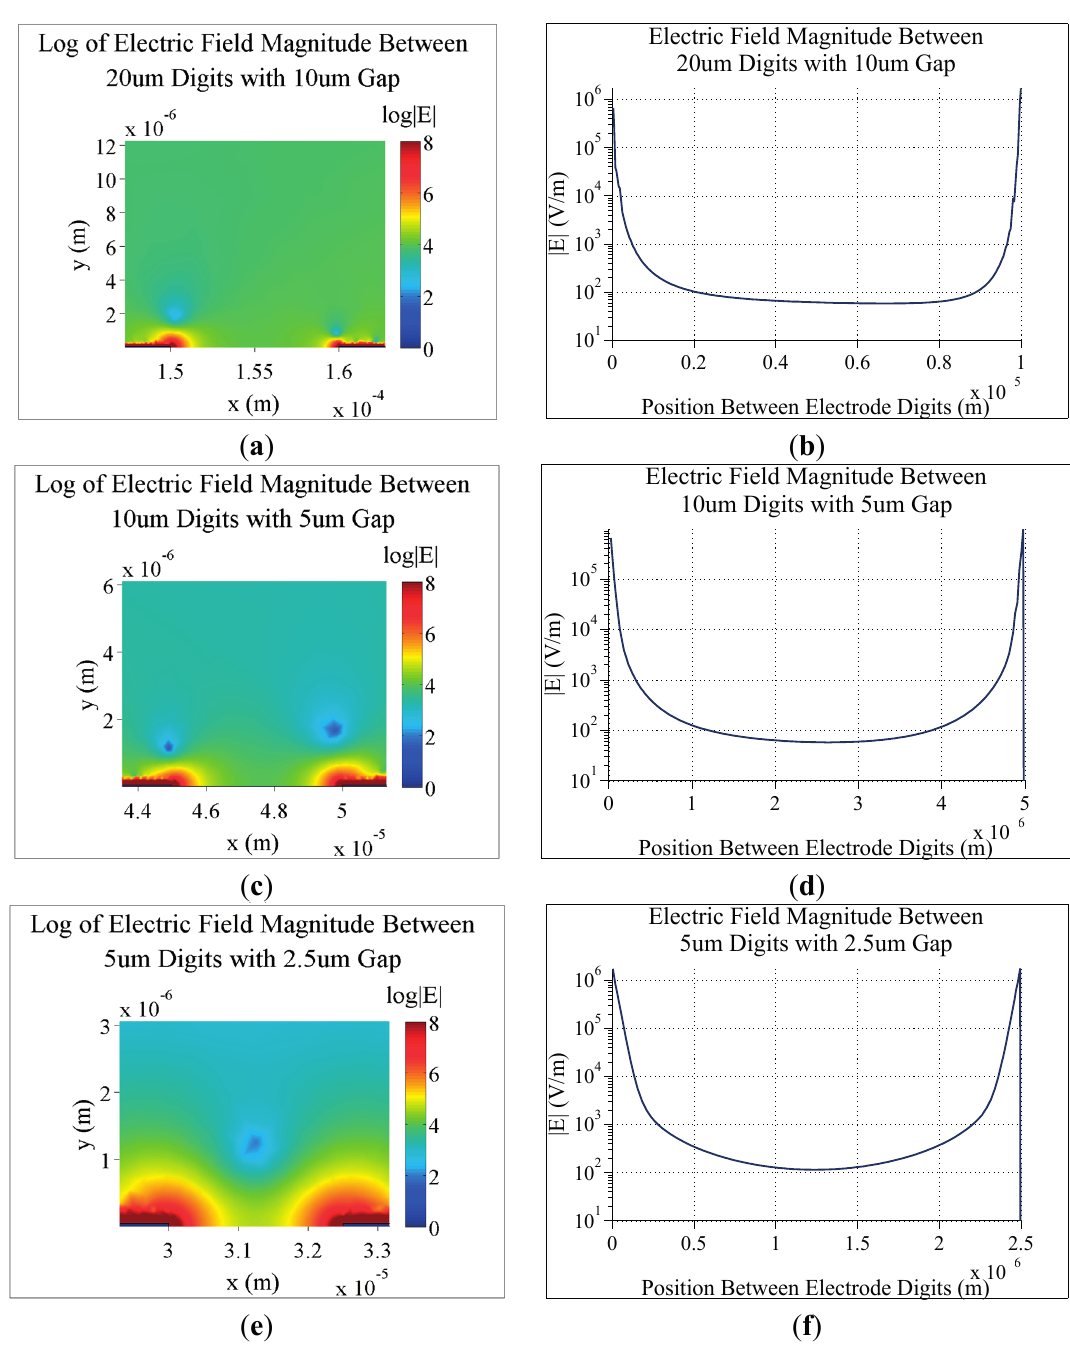
Figure 4. Simulations of the electric field magnitude for three different electrode configurations. In all cases, 0.1 V DC is applied to the electrodes, there is a background KCl concentration of 150 µM and simulations are shown after electric screening has developed. ( a ) Log of the electric field magnitude for 20 µm digits with 10 µm spacing; ( b ) The electric field magnitude between two of the digits from ( a ); ( c ) Log of the electric field magnitude for 10 µm digits with 5 µm spacing; ( d ) The electric field magnitude between two of the digits from ( c ); ( e ) Log of the electric field magnitude for 5 µm digits with 2.5 µm spacing; ( f ) The electric field magnitude between two of the digits from ( e